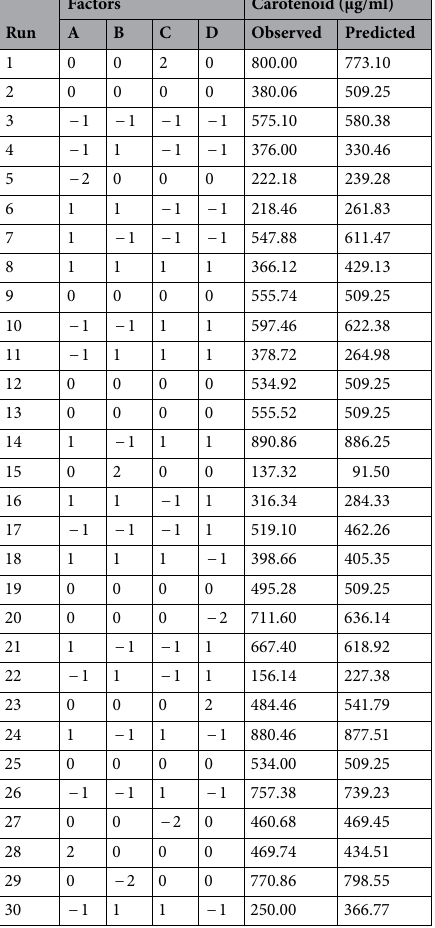
Table 2. The experiment design of RSM for the four independent variables affecting Kocuria sp. RAM1 carotenoids. A: Peptone (g/l), B: Temperature (°C), C: Agitation (rpm), D: Inoculum size